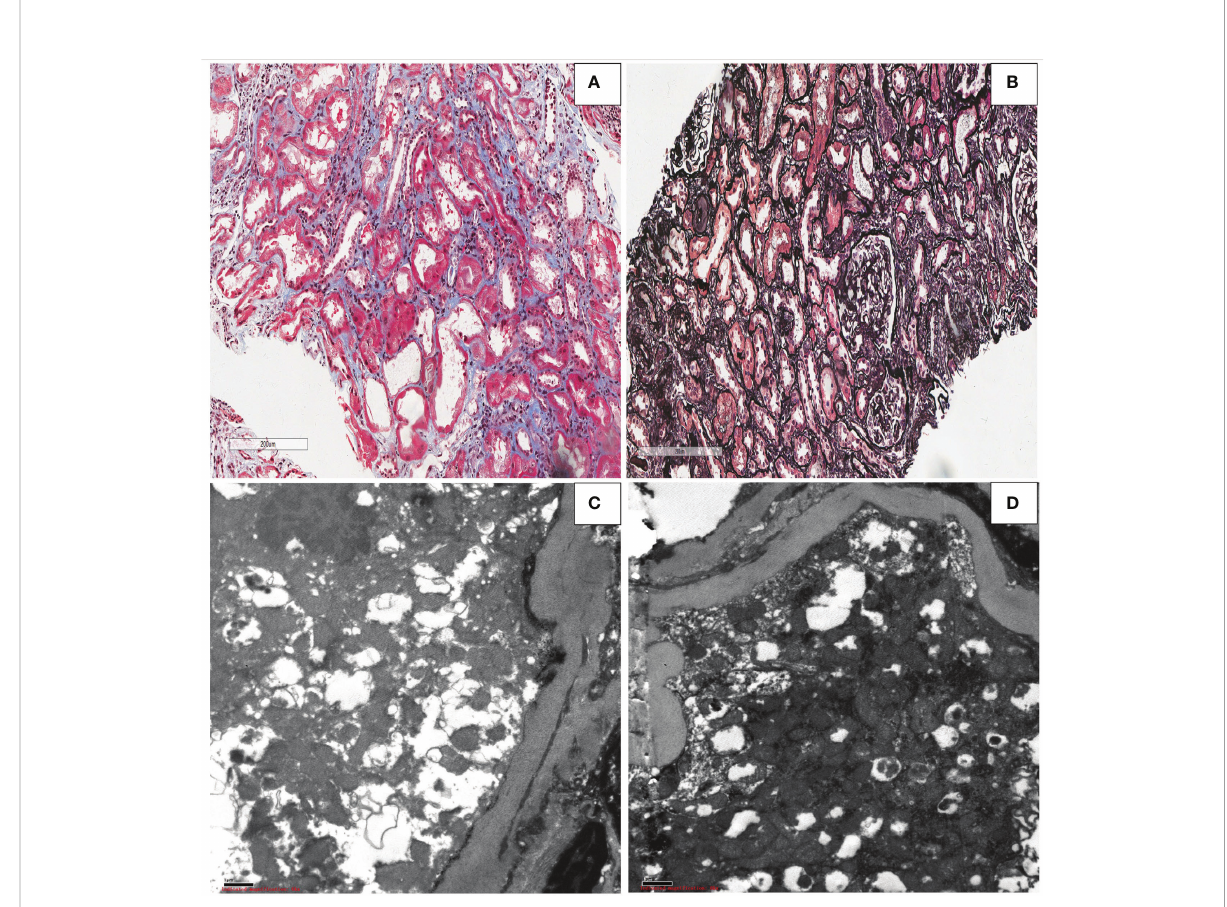
FIGURE 7 Kidney allograft biopsy fi ndings in the patient with Fanconi syndrome who was taking adefovir dipivoxil. (A) Light microscopy showing shedding of the epithelial cells of the renal tubules, exposed basement membrane, regeneration of some renal tubular epithelial cells, red blood cells in the lumen, and scattered in fl ammatory cells in the interstitium (Masson, original magni fi cation ×50). (B) Light microscopy showing renal tubular atrophy and interstitial fi brosis, renal vascular thickening, hyaline degeneration, and glomerular segmental sclerosis (periodic acid – Schiff, original magni fi cation ×50). (C, D) Electron microscopy showing swelling,deformity and morphological disorder of mitochondria in renal tubular epithelial cells (electron micrograph, original magni fi cation,